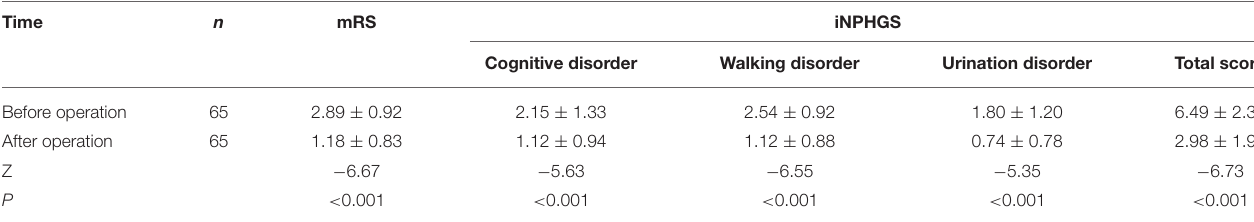
Paired-samples t-test; iNPH, idiopathic normal-pressure hydrocephalus; mRS, Modified Rankin Scale; iNPHGS, idiopathic normal-pressure hydrocephalus grading scale.